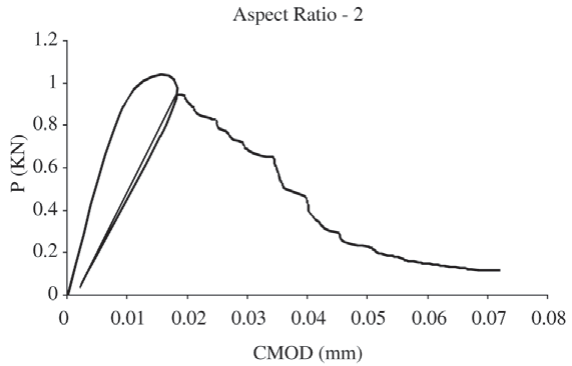
Figure 2. Load vs. CMOD curve for specimen with aggregate of aspect ratio